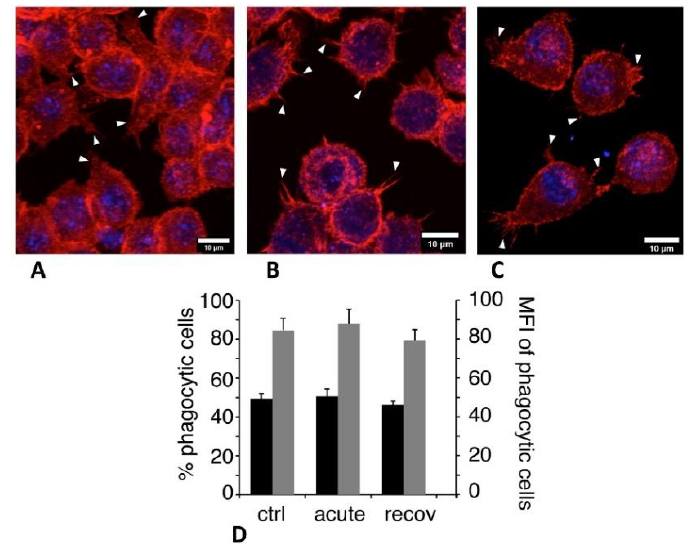
Figure 4. Actin cytoskeleton and phagocytosis. In panels ( A – C ), the actin cytoskeleton was visualized with fluorescent Atto 550 phalloidin (500 ng / mL) using LSM880 confocal microscopy. A Z-project reconstruction is shown for each condition. Examples of cytoplasmic projections (lamellipodia and filipodia) are indicated by white arrowheads. ( A ) Unexposed cells. ( B ) Cells exposed to pyrolytic silica for 24 h and analyzed just after exposure. ( C ) Cells exposed to pyrolytic silica for 24 h and left to recover without silica for 72 h. In panel ( D ), the phagocytic capacity was assessed by fluorescent latex beads internalization. Black bars: proportion of positive cells in the viable cell population; grey bars: mean cellular fluorescence of positive cells; ctrl: unexposed cells; acute: cells exposed to pyrolytic silica for 24 h and collected just after exposure; and recov: cells exposed to pyrolytic silica for 24 h and left to recover without silica for 72 h.